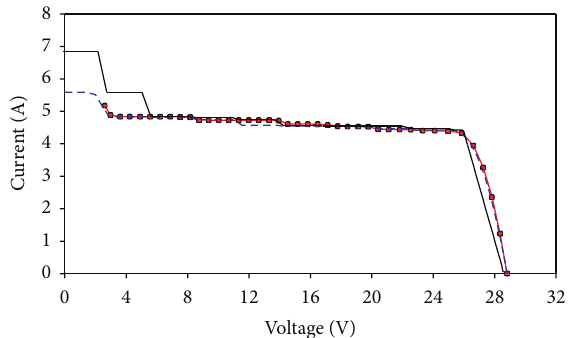
Table 3: Comparison between simulated (Matlab) and measured results of the dense-array CPV assembly is presented in terms